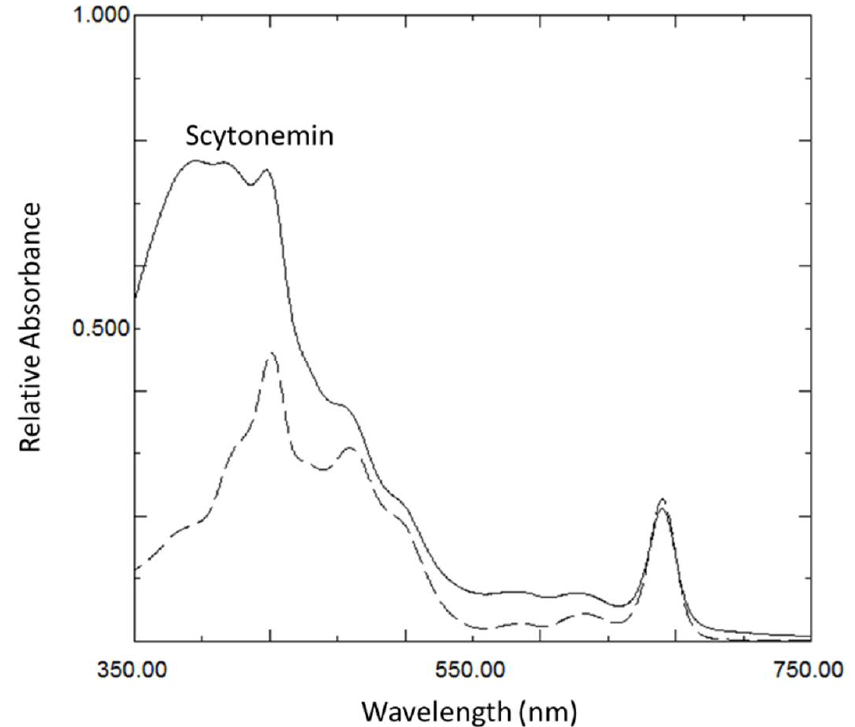
Figure 2. Representative absorption spectra of lipid-soluble pigments extracted from the cyanobac- terium Nostoc punctiforme after exposure to UVA for 48 h with scytonemin (solid line) compared to high light for 48 h without scytonemin (dashed line). The strong absorption at 384 nm is indicative of scytonemin. Similar results were obtained for UVB (similar to the solid line) as well as high light and osmotic stress (similar to the dashed line).